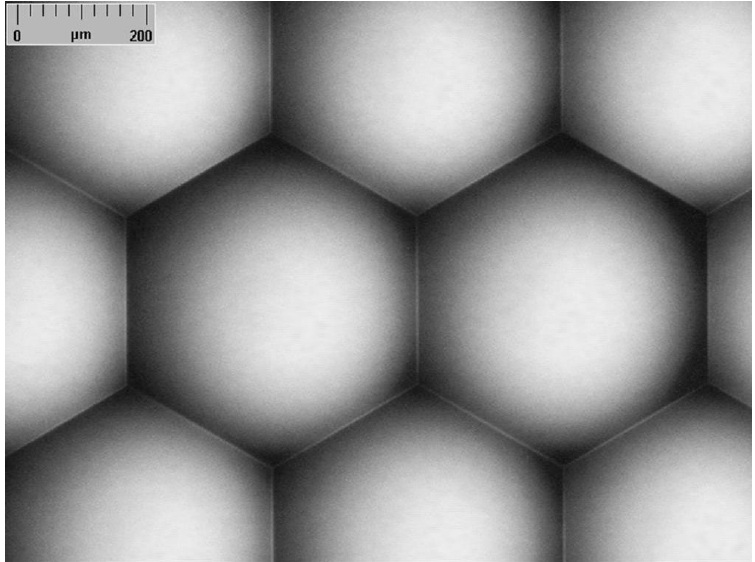
Figure 5. Microscope photograph of a UV molded hexagonal convex lens array with 100% fill